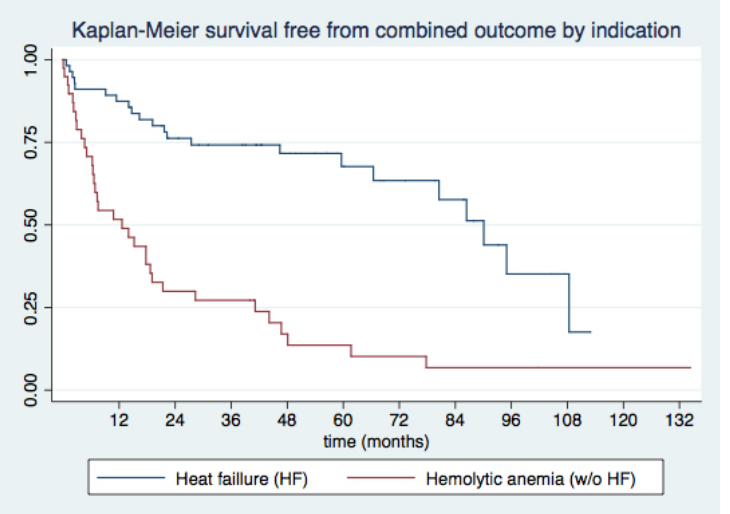
Figure 4. Survival free from major adverse cardiovascular events (MACE) according to indication for PVL closure. PVL